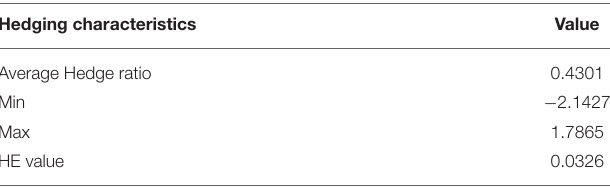
TABLE 8 | Basic information of the dynamic hedging strategy for further discussion.